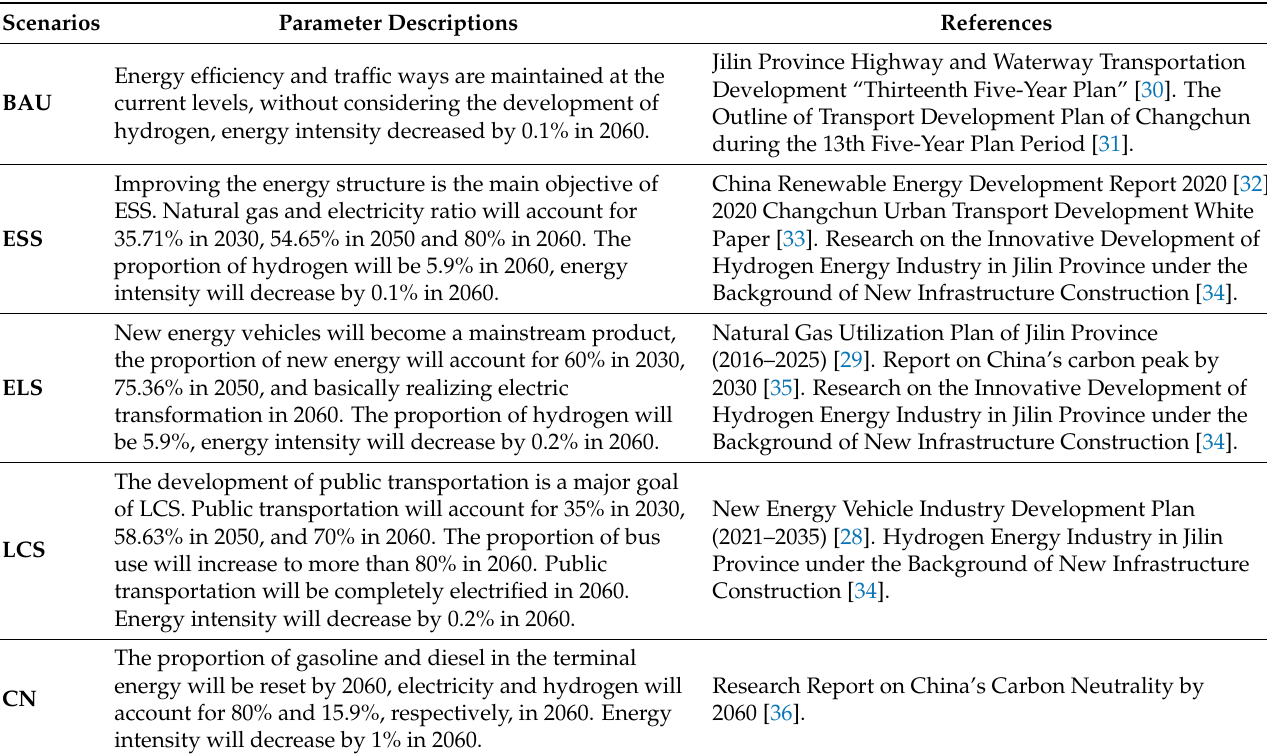
Table 1. Parameter settings under different